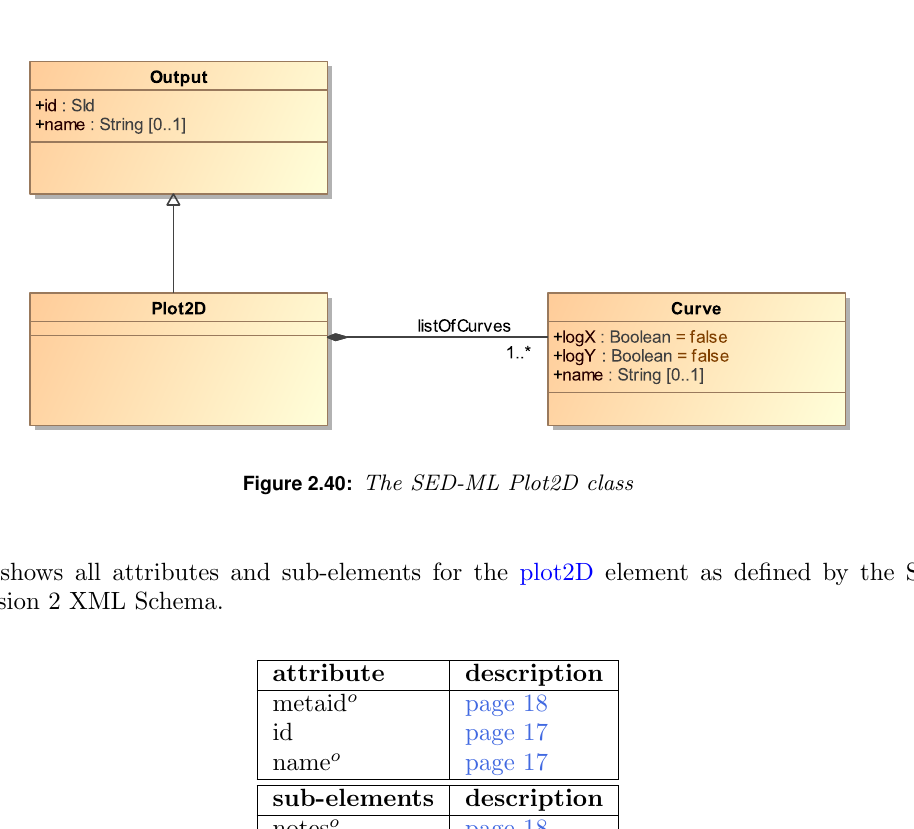
Table 2.24: Attributes and nested elements for output. xy o denotes optional elements and attributes.